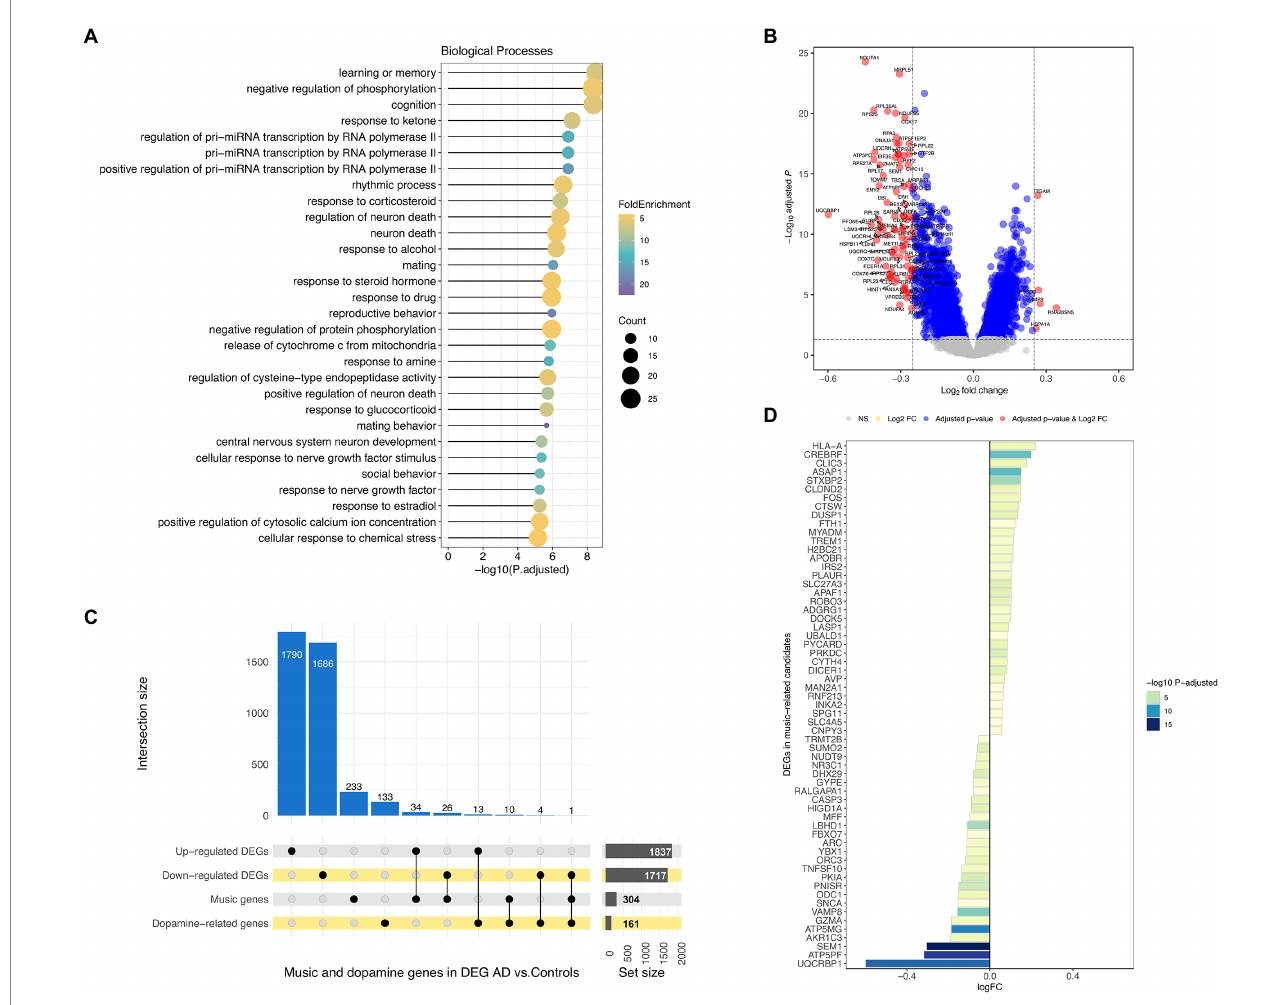
FIGURE 4 (A) Over-representation analysis of GO (Gene Ontology) terms using music-related candidate genes as input. Only the biological processes category was interrogated. (B) Volcano plot showing differentially expressed genes between AD patients and controls from the meta-analysis. (C) Upset plot of commonalities between up- and downregulated genes in AD patients, music-related and dopamine-related genes. (D) Differentially expressed genes in AD patients included in the music-related